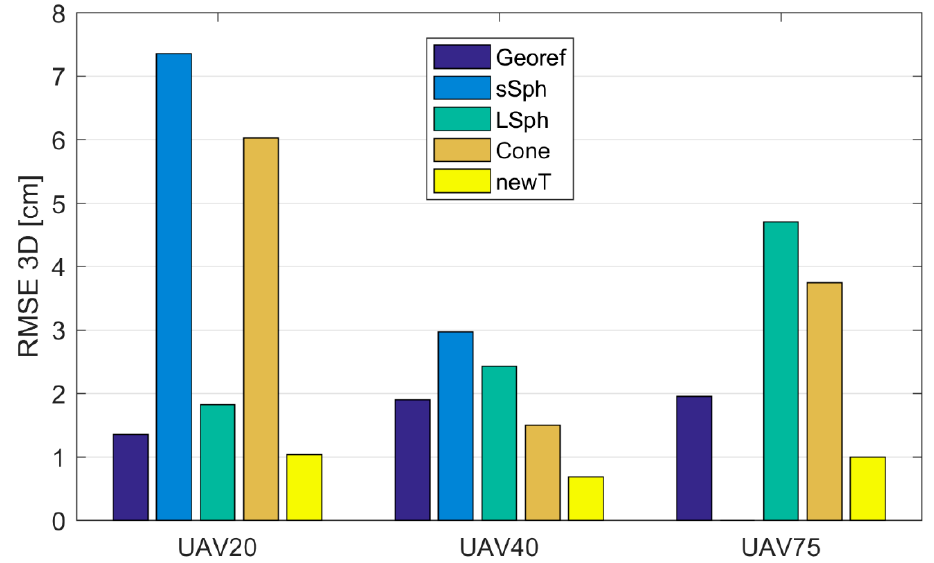
Figure 13. The 𝑅𝑀𝑆𝐸 (cid:2870)(cid:3005) on check points, following the registration of UAV and TLS point clouds, taking into account the used tie point, given in cm. “Georef” represents the RMSE prior to the registration of the TLS and UAV point clouds.